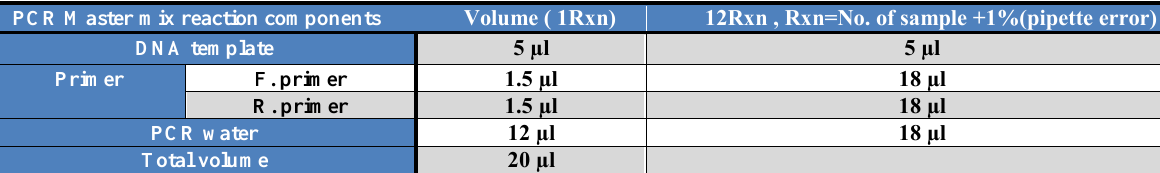
Table, 1: Shows Components of PCR Master Mix